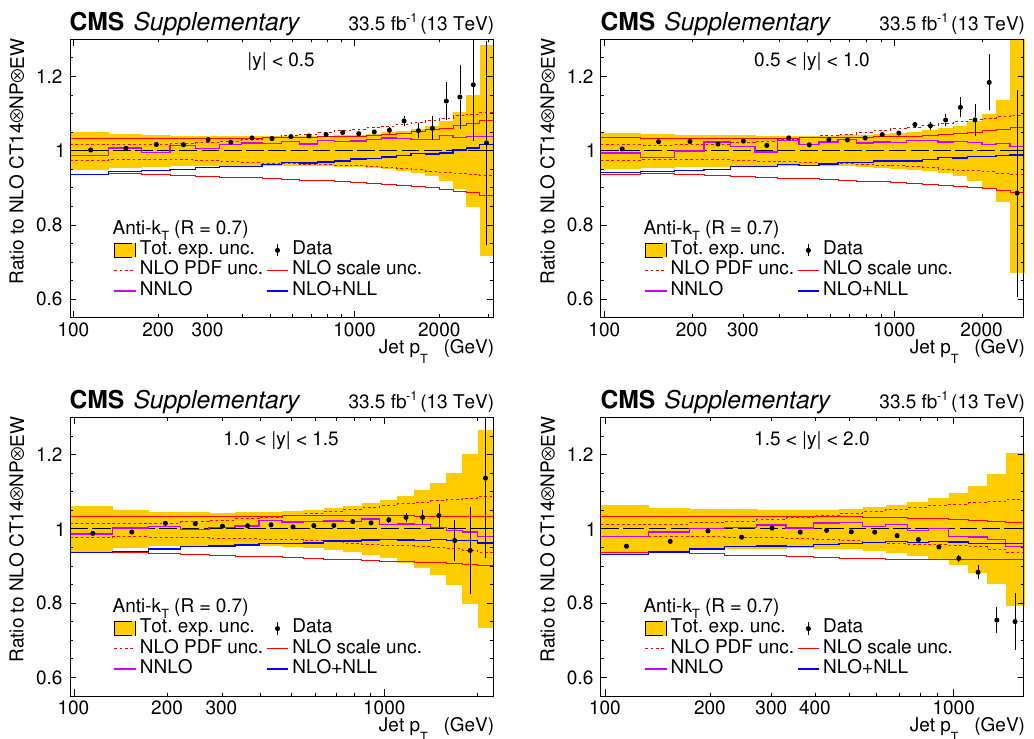
Figure 22 . Same as figure 20 for the distance parameter R = 0 . 7